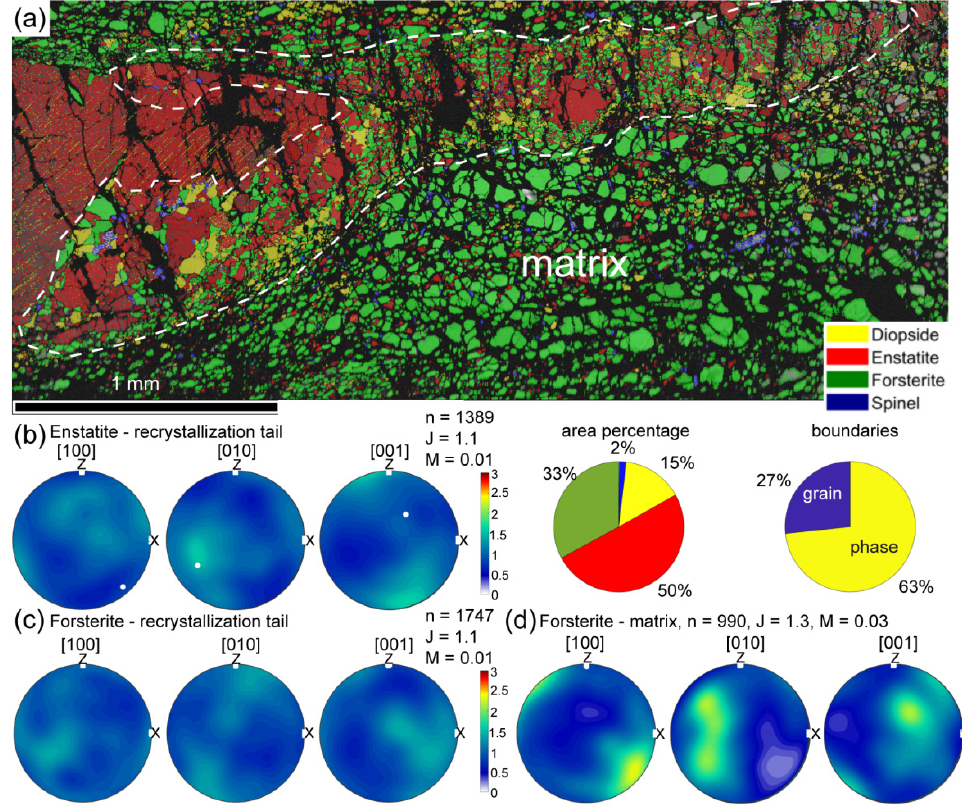
Figure 9. ( a ) Phase map of an opx porphyroclast with a recrystallization tail (dashed line) within the olivine matrix; also indicated are the area percentages of the phases and the amount of grain and phase boundaries of the recrystallization tail (ROI25). ( b ) Pole figure of enstatite orientations in the recrystallization tail. The white dot shows the orientation of the opx porphyroclast. ( c ) Pole figure of forsterite orientations in the recrystallization tail. ( d ) Pole figure of forsterite orientations in the matrix.